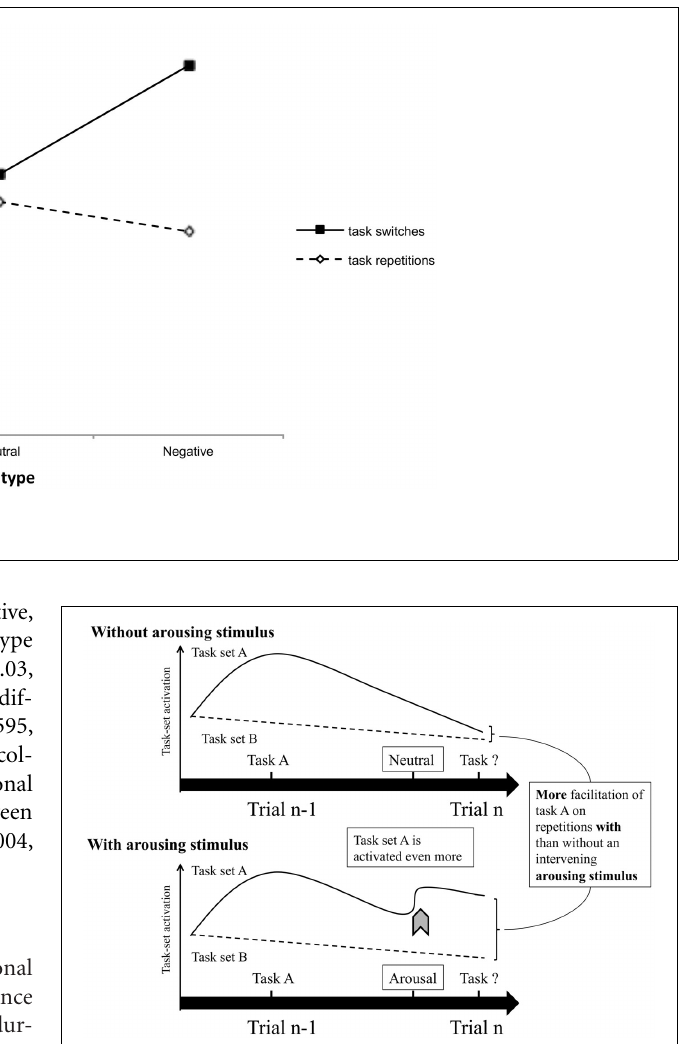
FIGURE 4 | Scheme of the application of the noradrenalin account of Verguts and Notebaert (2009) on the switch cost